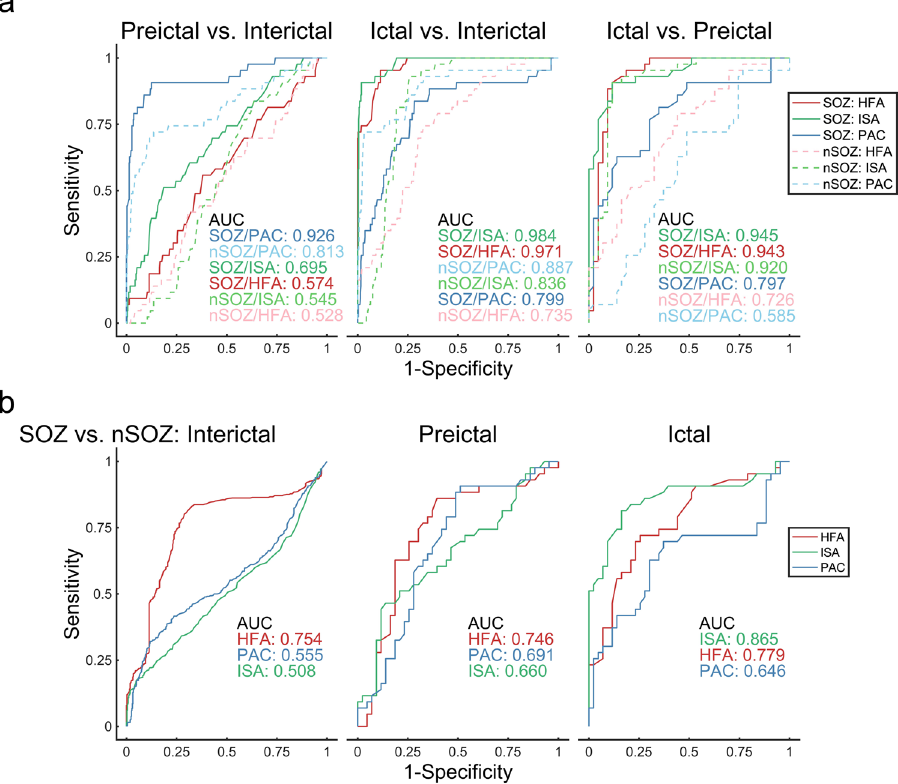
Figure 6. Average receiver operating characteristic curves of the results, after stage classification. ( a ) Preictal vs. interictal, ictal vs. interictal, and ictal vs. preictal stages are classified using HFA amplitude, ISA, and PAC (i.e., ISA-HFA SIm) of the SOZ contacts or the nSOZ contacts. SOZ-PAC shows the highest performance between the preictal and interictal states, whereas SOZ-ISA has a higher potential to distinguish between the ictal and interictal states and between the ictal and preictal states. ( b ) On classifying SOZ and nSOZ using HFA, ISA, and PAC, we found that HFA has the maximum AUC in the interictal and preictal states. ISA performs best in the ictal